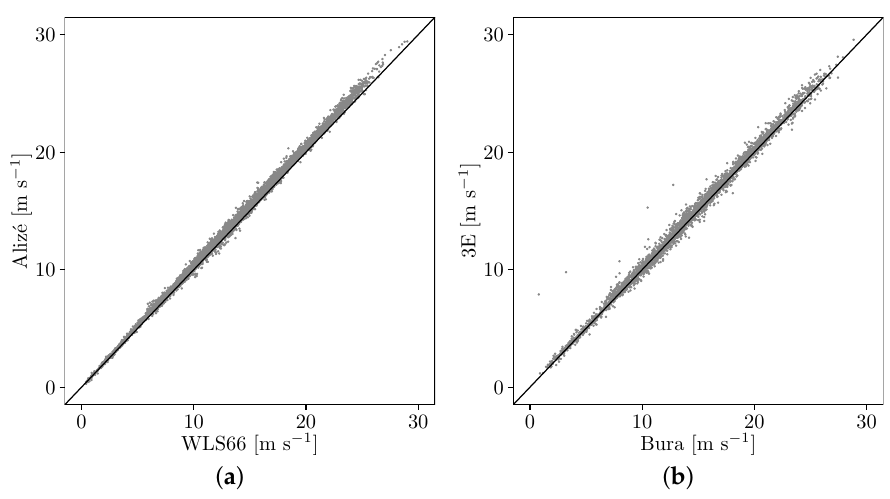
Figure 8. Scatter plots of 10 min mean wind speeds at 150 m ASL for Bura and 3E ( b ). A line through the origin with a slope of 1 is shown in black.